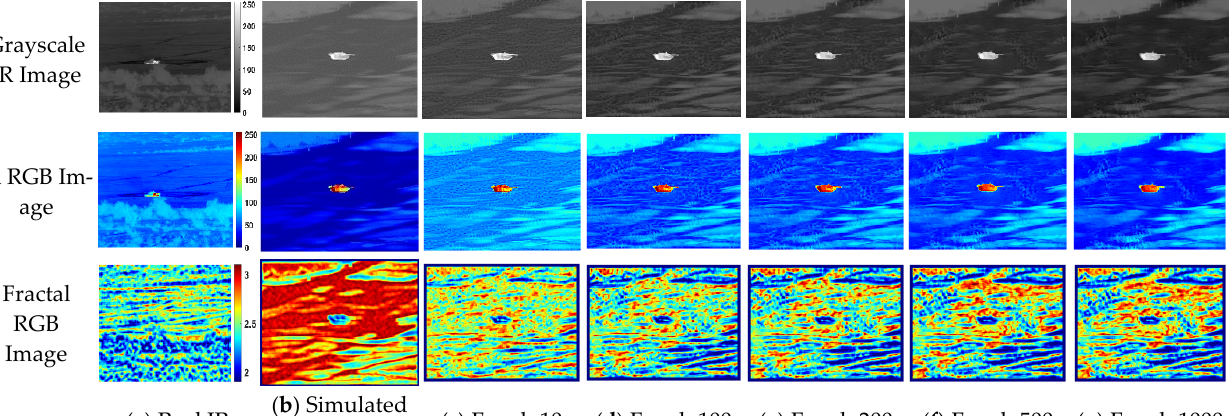
Figure 3. Evolving image features of the grayscale infrared image, false-color infrared image, and fractal image in each of the three simulation conditions: ( A ) Cloudy summer weather at 20 h; ( B ) Fine summer weather at 20 h; ( C ) Cloudy summer weather at 10 h. Each column shows seven different infrared image types: ( a ) Real IR image as a style reference; ( b ) Simulated IR image as a content reference; ( c ) Style-transferred simulated IR image at epoch 1; ( d ) Style-transferred simulated IR image at epoch 100; ( e ) Style-transferred simulated IR image at epoch 200; ( f ) Style-transferred simulated IR image at epoch 500; ( g ) Style-transferred simulated IR image at epoch 1000.